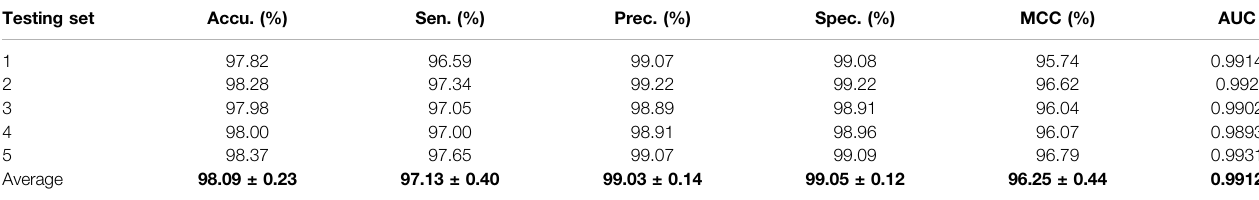
The bold values in these Tables mean the highest value in every column.